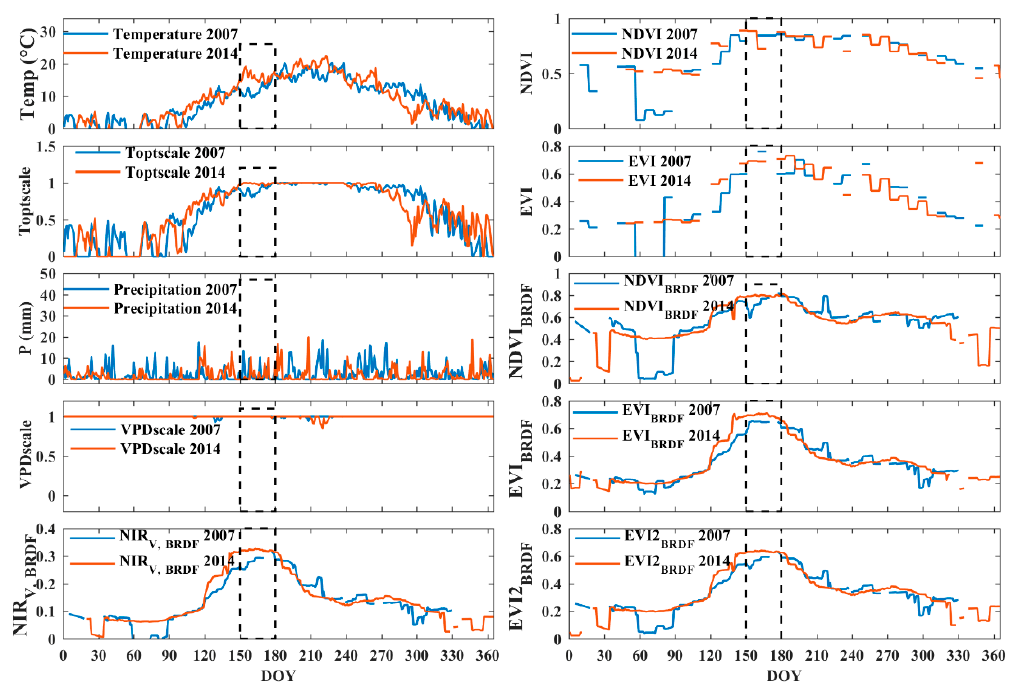
Figure 9. Daily VIs, temperature, precipitation, temperature stress (f Topt ) and water stress (f VPD ) at a deciduous broadleaf forest site (DK-Sor) in a normal year (2014) and a low temperature year (2007).